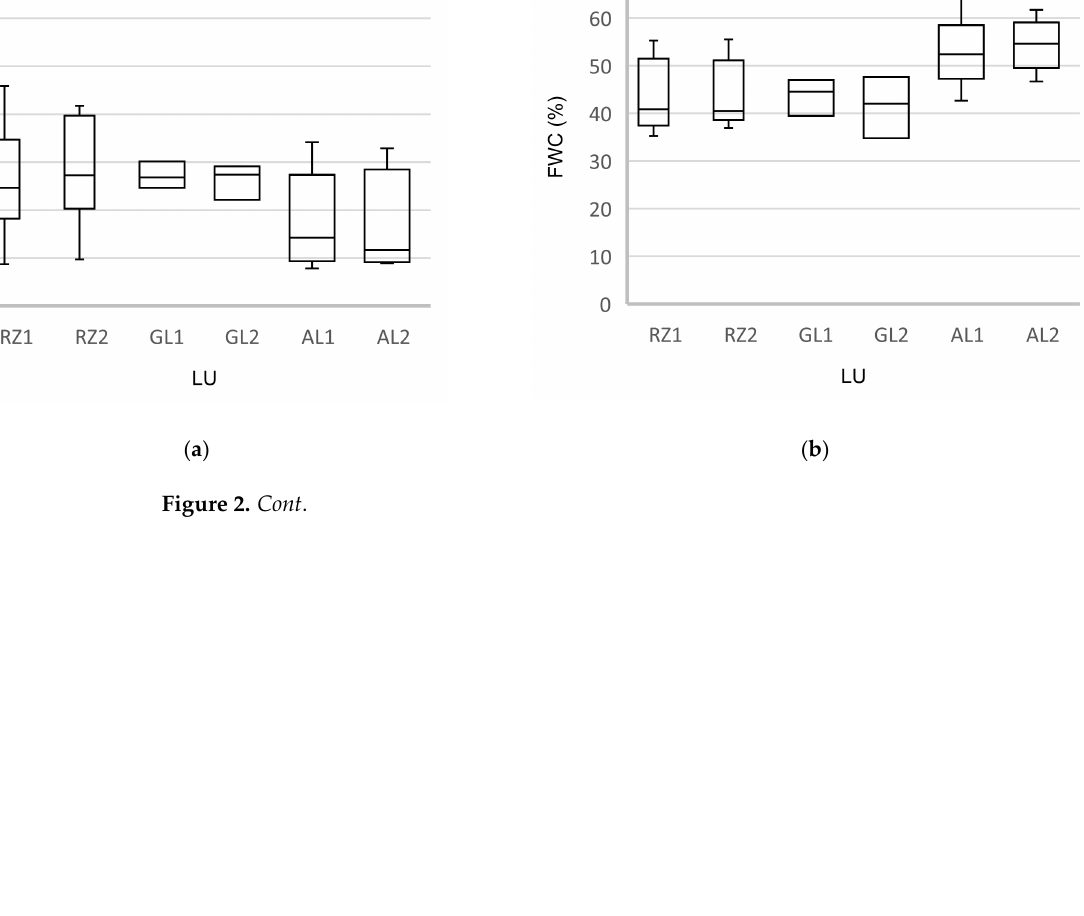
( e ) Figure 2. ( a ) Actual soil moisture on September 10, 2018 (SMa); ( b ) Field water capacity (FWC); ( c ) Wilting point (WP); ( d ) Available water capacity (AWC); ( e ) Soil water deficit index (SWDI). RZ— Riparian zone, GL—Grassland, AL—Arable land, 1—Depth 0–10 cm, 2—Depth 20–30 cm.